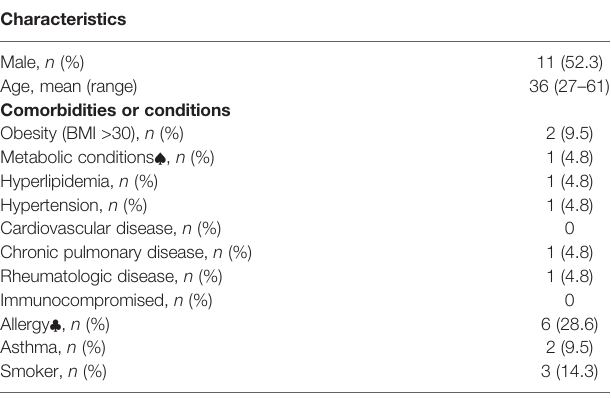
TABLE 1 | Demographic and baseline characteristics of enrolled volunteers.